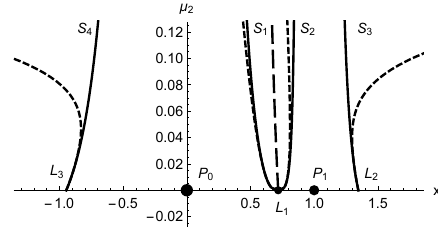
Figure 5. Approximate (dashed curves) and numerical (solid curves) solutions for S